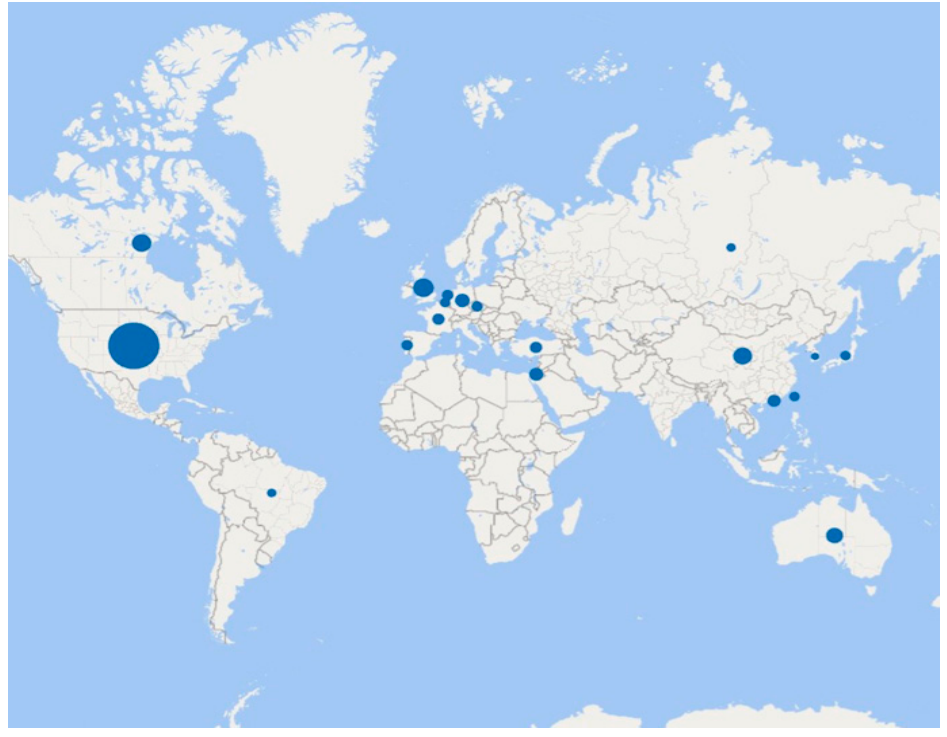
Figure 2. Main geographic distribution of the studies included in this review.